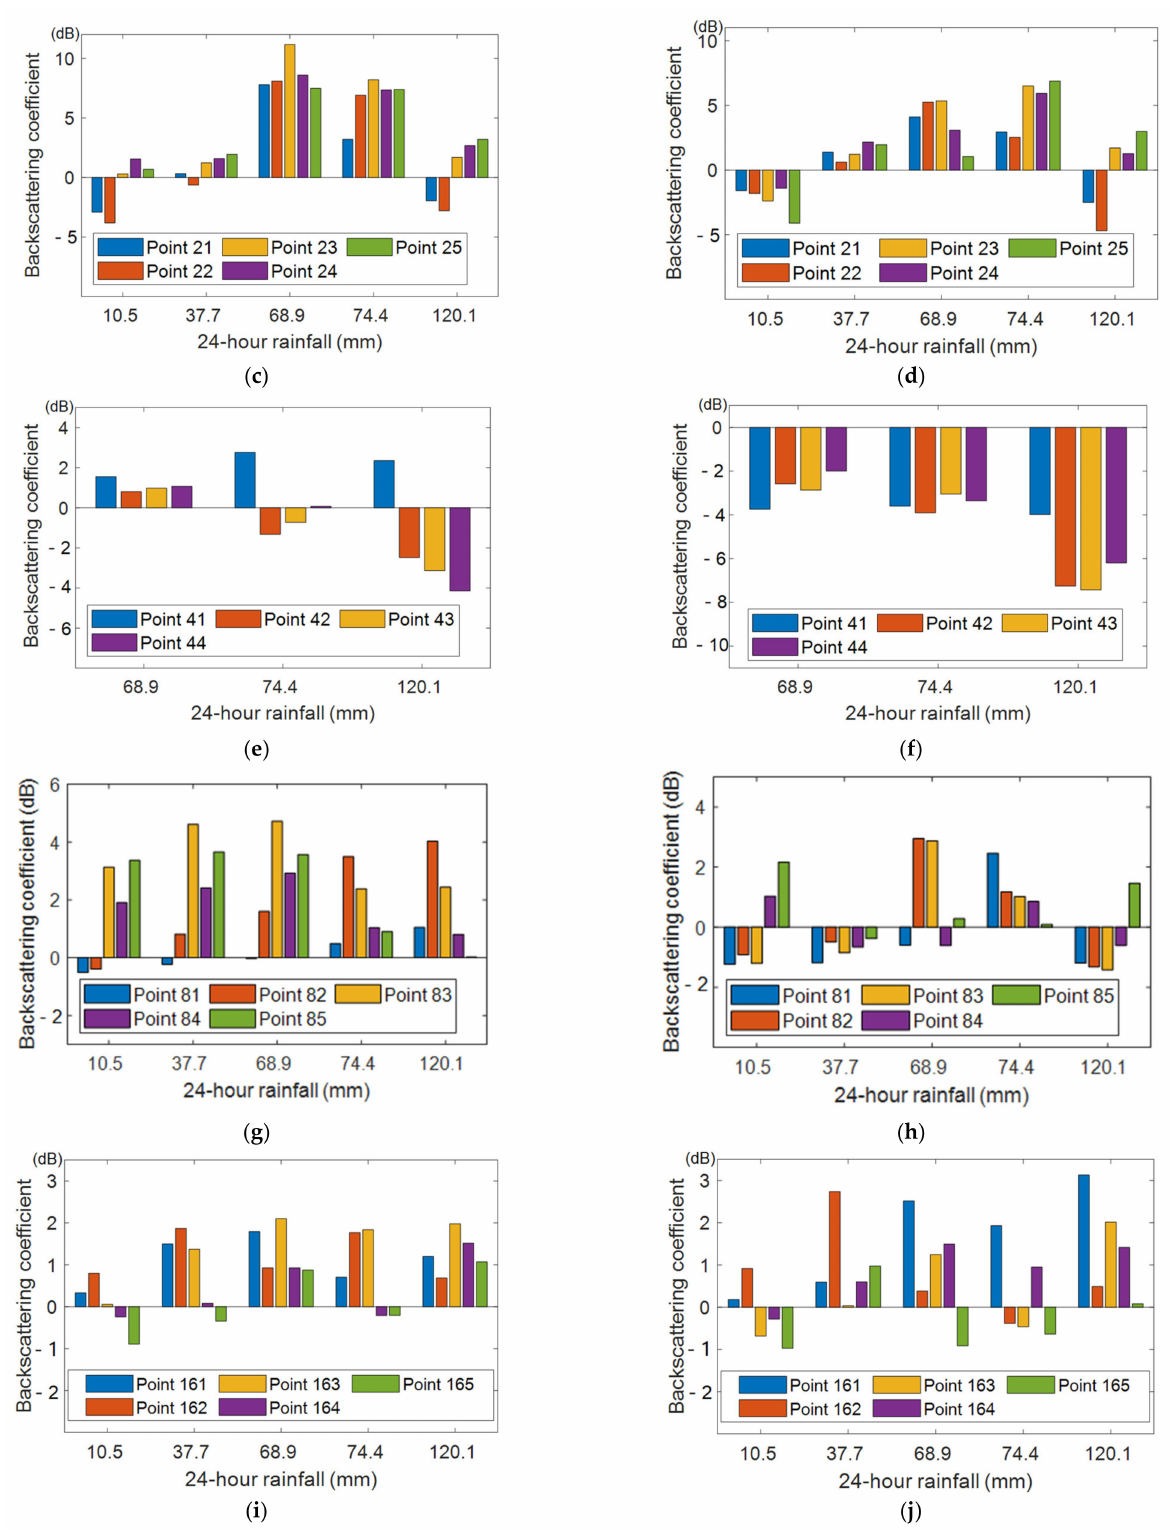
Figure 11. Relative backscattering coefficients changes in each category: ( a ) Water body—VH; ( b ) Water body—VV; ( c ) Farmland—VH; ( d ) Farmland—VV; ( e ) Farmland with plastic sheds—VH; ( f ) Farmland with plastic shed—VV; ( g ) Road—VH; ( h ) Road—VV; ( i ) Construction—VH; ( j )